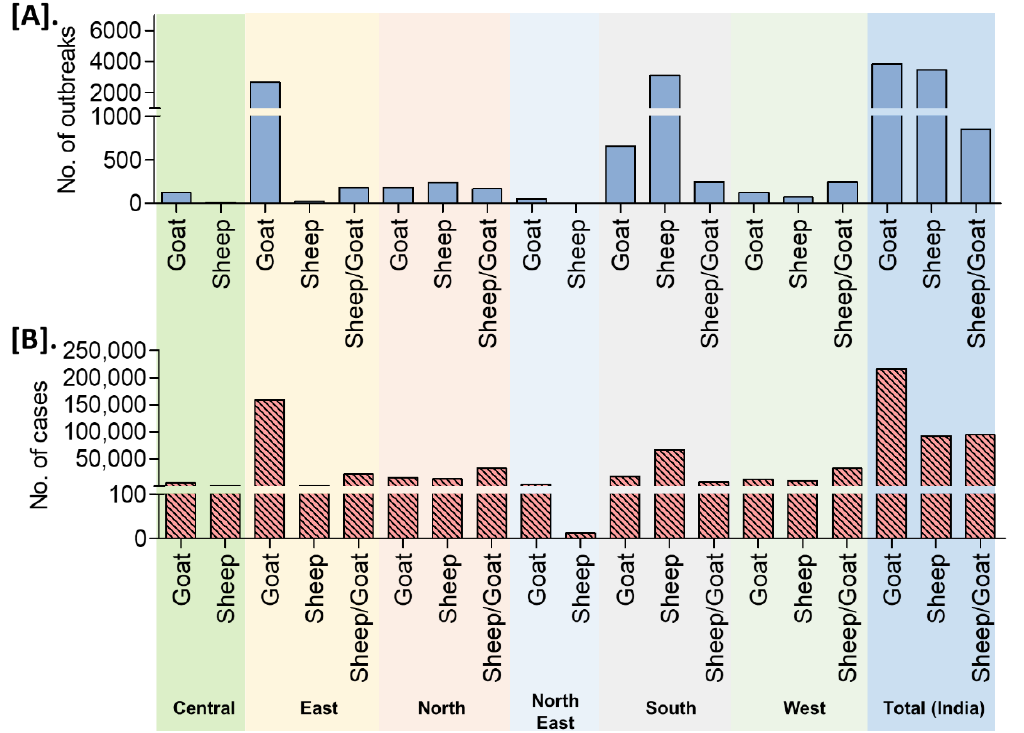
Figure 8. Species-wise occurrence of cumulative PPR reports in different zones/regions of India (1995–2019). ( A ). Outbreaks ( B ). Cases. An increased number of outbreaks have been reported in goats than in sheep in the different zones of the country, except in the south zone where the number of outbreaks was greater in sheep.